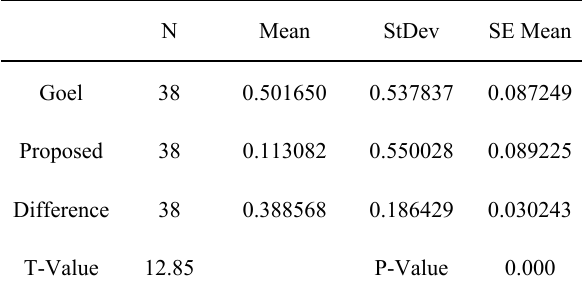
Table 4. Goel-Okumoto Model and the Proposed Model in Paired T Test